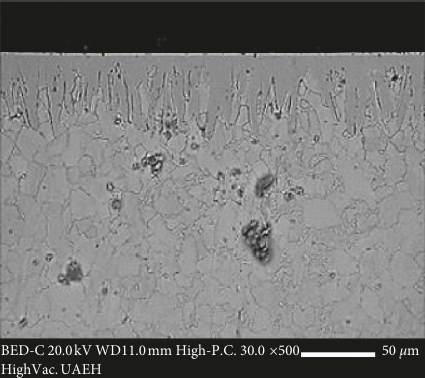
Figure 10: Scanning electron microscopy (SEM) image of the microstructure of boride layer (Fe 2 B) formed on the ASTM A36 steel during powder pack at 1123K with an exposure time of